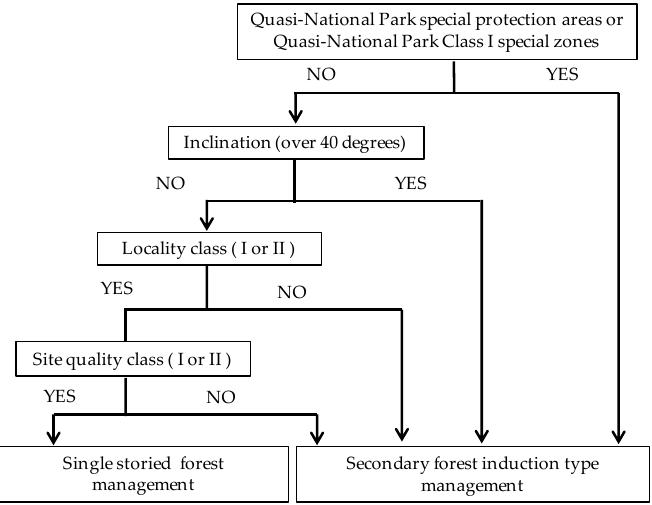
Figure 6. Environmental plan with greater emphasis on site quality class (Plan 4).